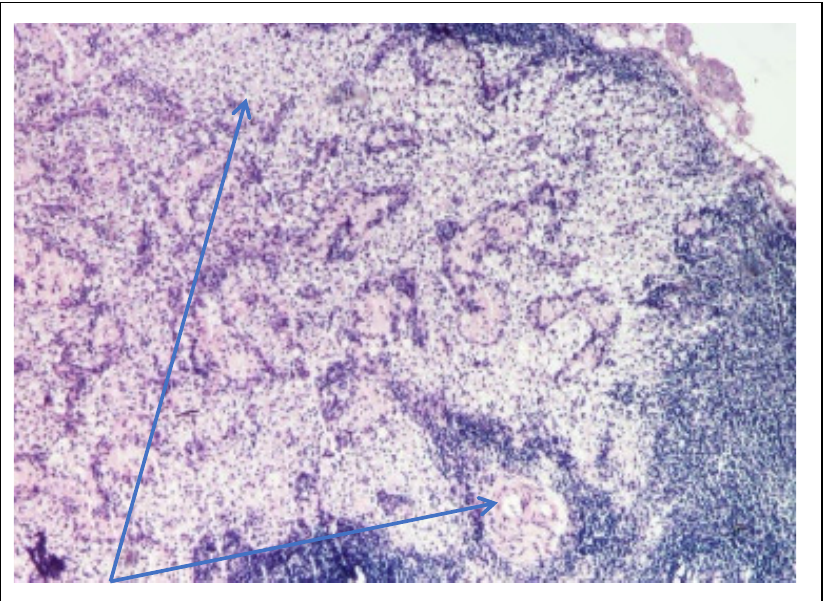
Figure 12. Mesenteric ganglion biopsy ( PAS staining × 100)—areas of macrophages with foamy cytoplasm (blue arrow).